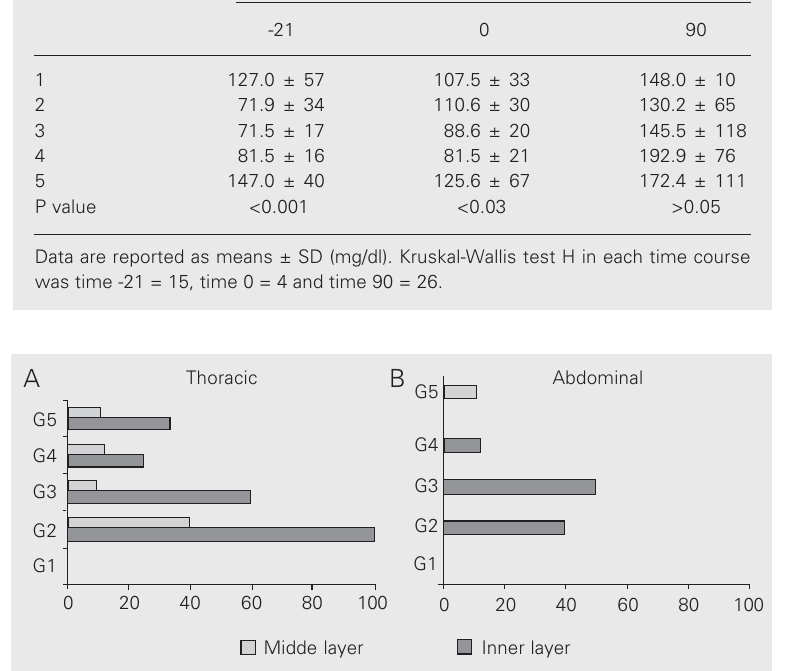
Table 2. Serum triglyceride levels at surgery (21 days before randomization: -21), 21 days after surgery (time of randomization: 0), and at the end of follow-up (90). Group